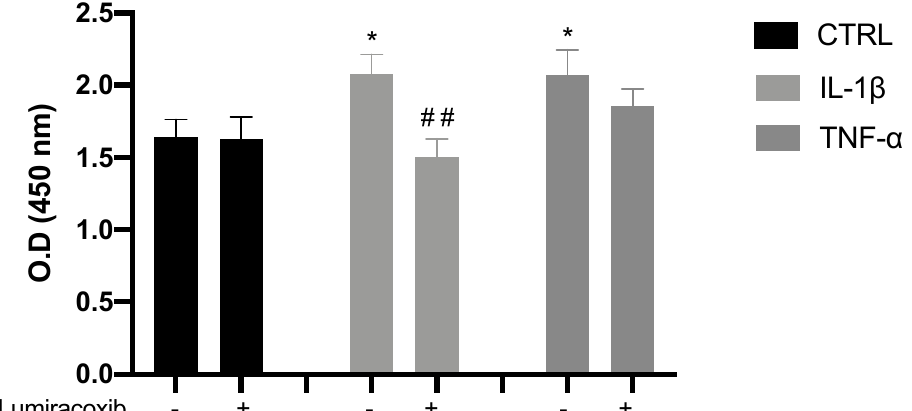
Figure 3. IL-1 β effect on myoblast proliferation is mediated by COX-2 activity. Pharmacological inhibition of COX-2 with lumiracoxib leads to a reduction in proliferation, which was increased by IL-1 β (gray), in comparison with control cells (black, treated with vehicle 0.1% Tween-80). The TNF- α effect (dark gray) was not affected by lumiracoxib. Data are shown as mean ± SEM (* p < 0.05 vs. control; ## p < 0.01 vs. IL-1 β from unpaired t -test).